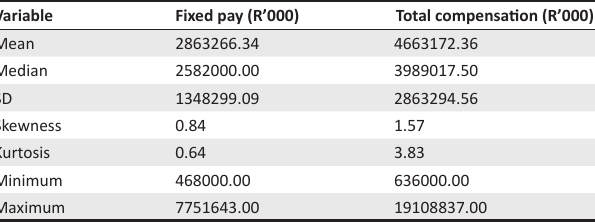
TABLE 2: Chief executive officer compensation components for dataset